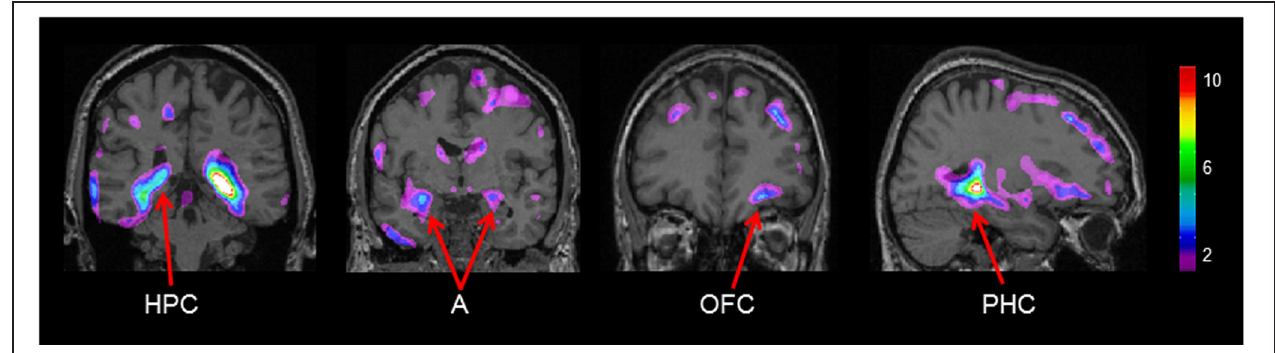
FIGURE 4 | Regions of the brain that co-varied with our peak hippocampal gray matter value ( x = 26 . 0, y = − 37 . 8, z = − 3 . 2). A, Amygdala; HPC, hippocampus; PHC, parahippocampal cortex; OFC, orbitofrontal cortex. The color bar illustrates the range of t statistical